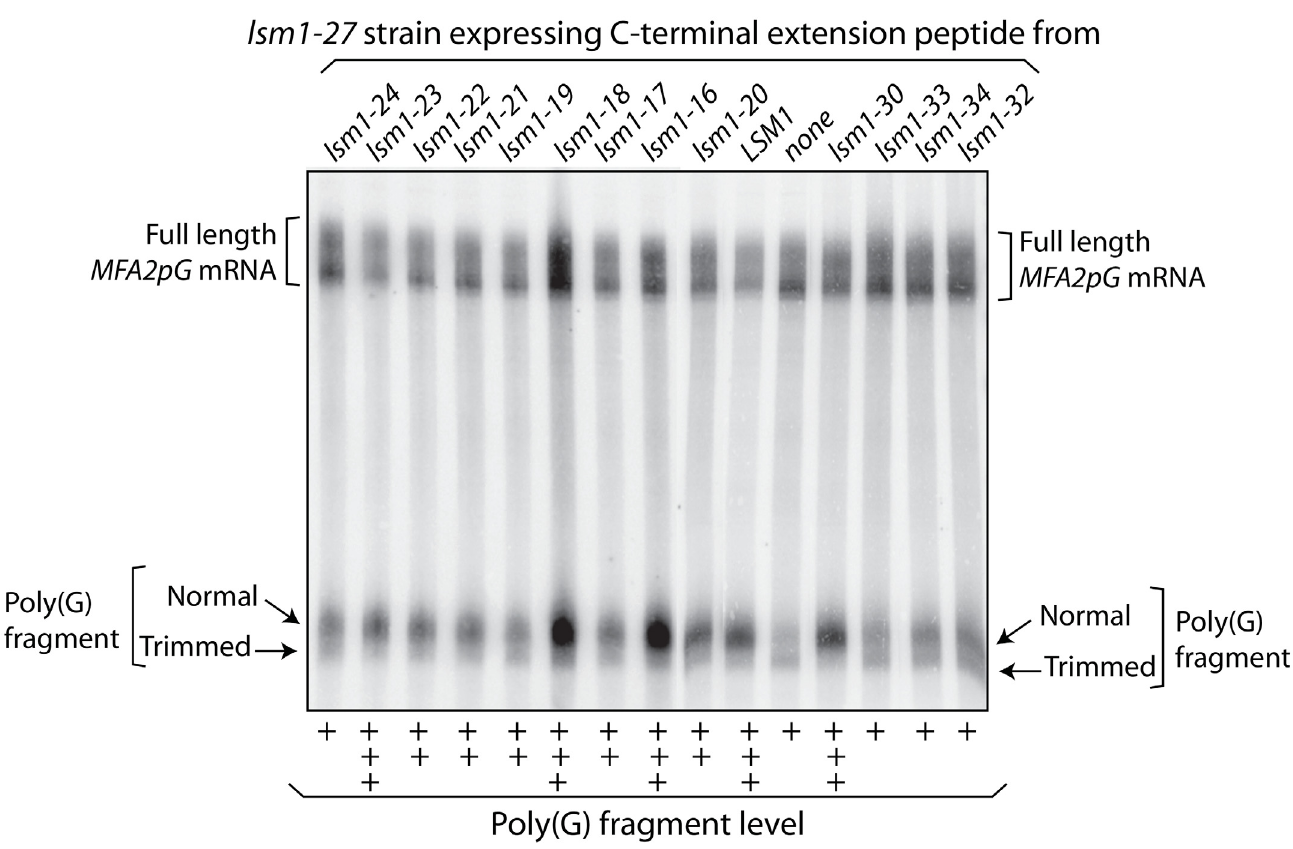
Fig 2. Suppression of the mRNA decay phenotype of the lsm1-27 mutant (C-terminal truncation mutant of LSM1 ) in trans by the various mutant versions of the C-terminal extension peptide, upon over expression. RNA isolated from lsm1-27 cells expressing wild type or various mutant versions of the C-terminal extension peptide of Lsm1 from multi copy 2 μ vectors were subjected to Northern analysis to reveal the MFA2pG mRNA and the poly(G) fragments. The fractional contribution of the poly(G) fragments to the total signal (total = full-length mRNA + trimmed and normal poly(G) fragments) was approximated for each sample via quantitation using the phosphorimager and normalized to the value obtained for lsm1-27 cells expressing wild type C-terminal extension peptide. Samples with approximate poly(G) fragment levels that are (cid:1) 80%, 60% to 80% and < 60% of the value for cells expressing wild type peptide are marked with +++, ++ and + below the corresponding lanes in the figure.